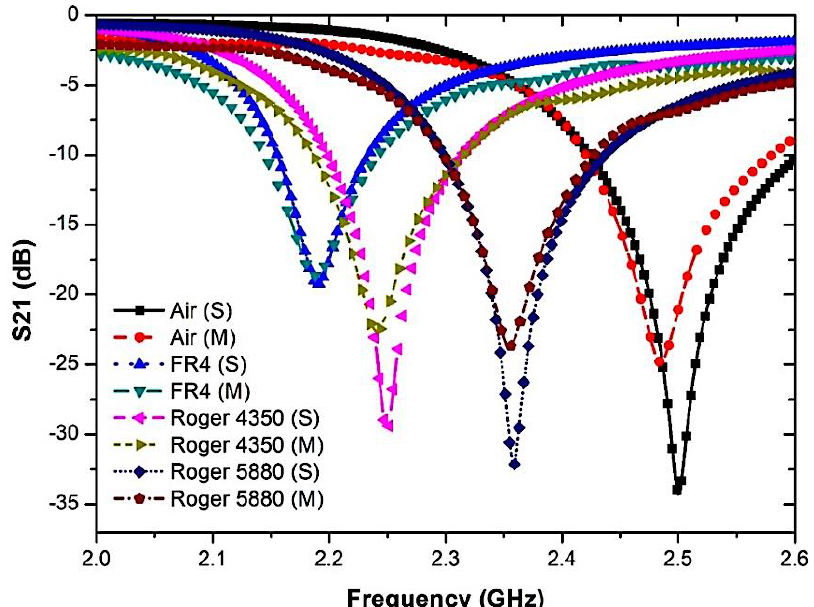
Figure 15. Comparison of simulated and measured curve-feed CSRR sensor with the presence of solid samples.